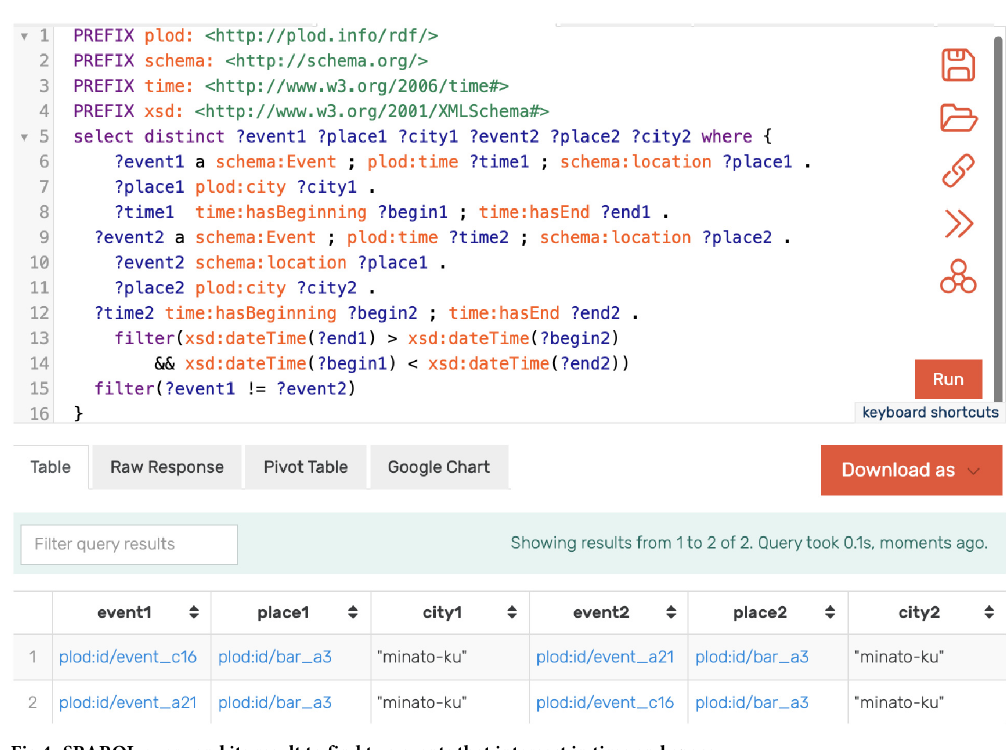
Fig 4. SPARQL query and its result to find two events that intersect in time and space.